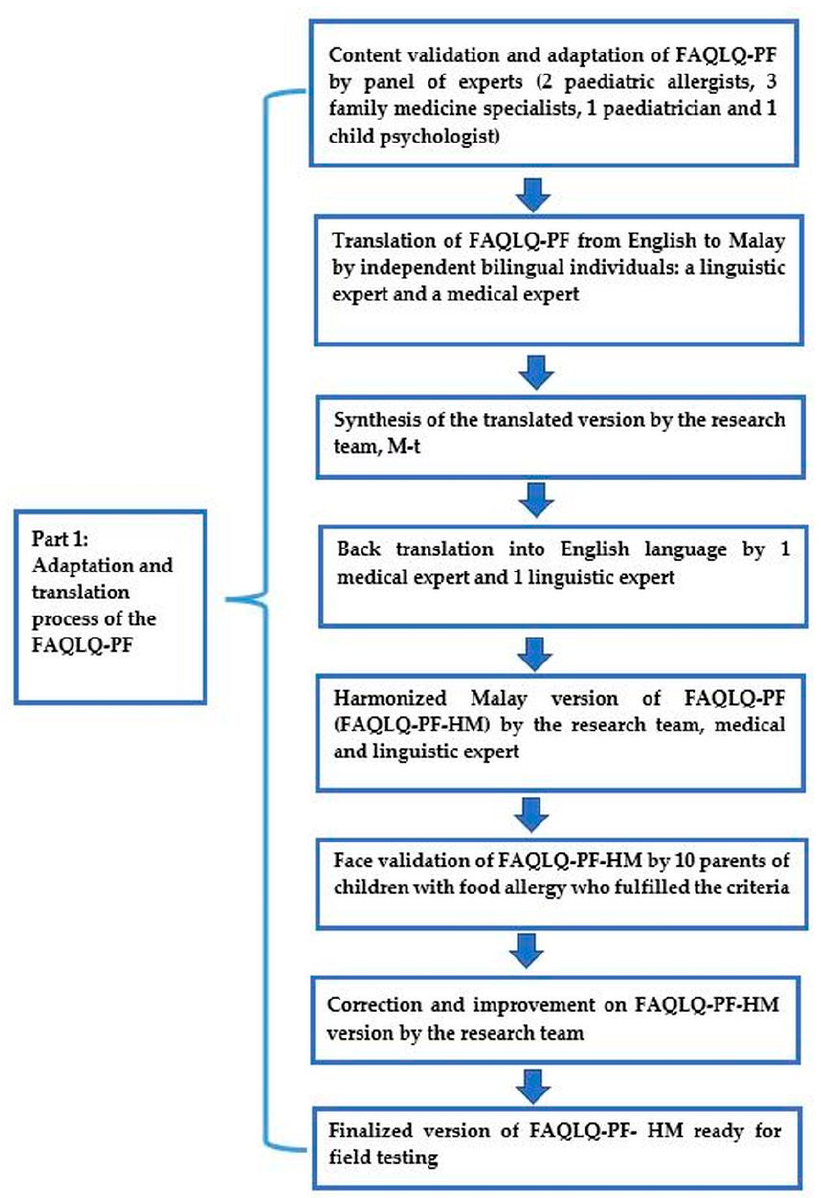
Figure 1. Part 1 flow chart. FAQLQ-PF-HM: Food Allergy Quality of Life-Parent Form-Harmonized Malay